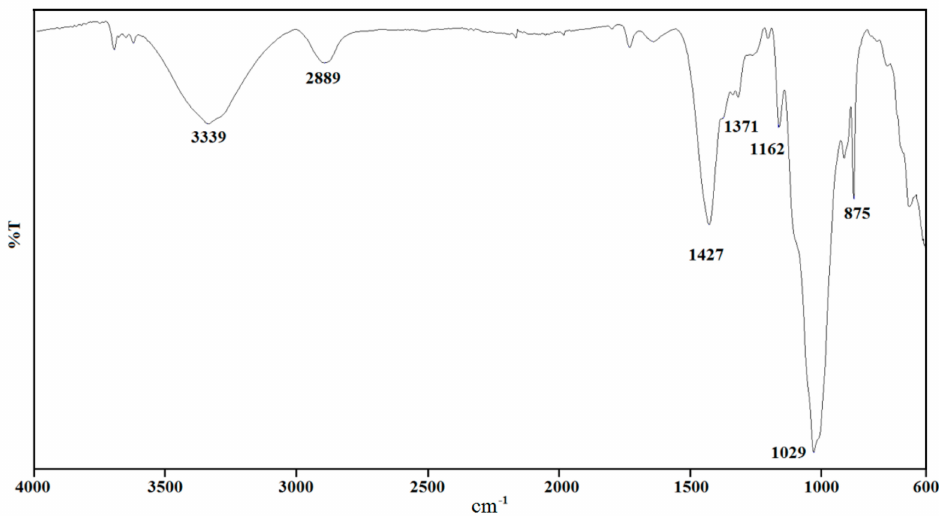
Figure 1. ATR FT-IR spectrum of untreated metal-coated paper.